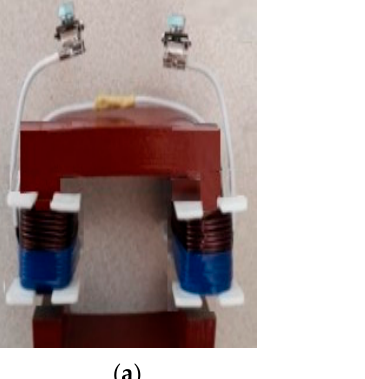
Figure 11. Split-core current transformer type ISN 3R 600 A/5 A class 0.5: in the housing ( a ), interior ( b ), and its numerical Model 1 ( c ).